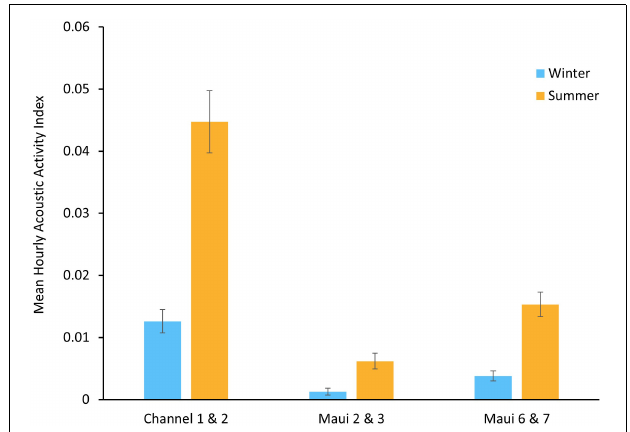
that hours that fall between sunrise and noon will have greater mean AAI than those that do not with nighttime hours having the lowest mean AAI ( Figure 5B ). The cyclic smoother for month reflects the pattern seen in Figure 4 of greater mean hourly AAI in summer months than winter months ( Figure 5C ).